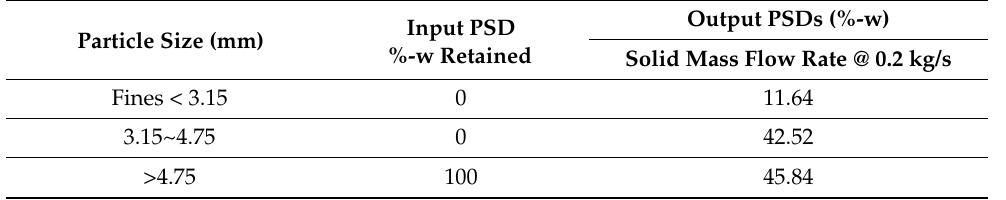
Table 11. Degradation of coffee beans with an air flow rate of 0.27 kg/s and feeder speed of 10 RPM while conveying through a pipeline having bends in